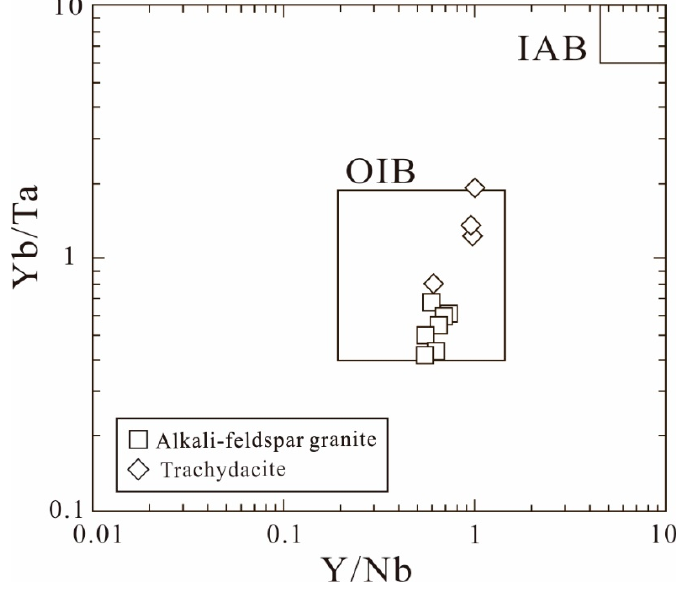
Figure 9. Y/Ta vs. Y/Nb diagrams for A-type granite [9]. Figure 9. Y / Ta vs. Y / Nb diagrams for A-type granite